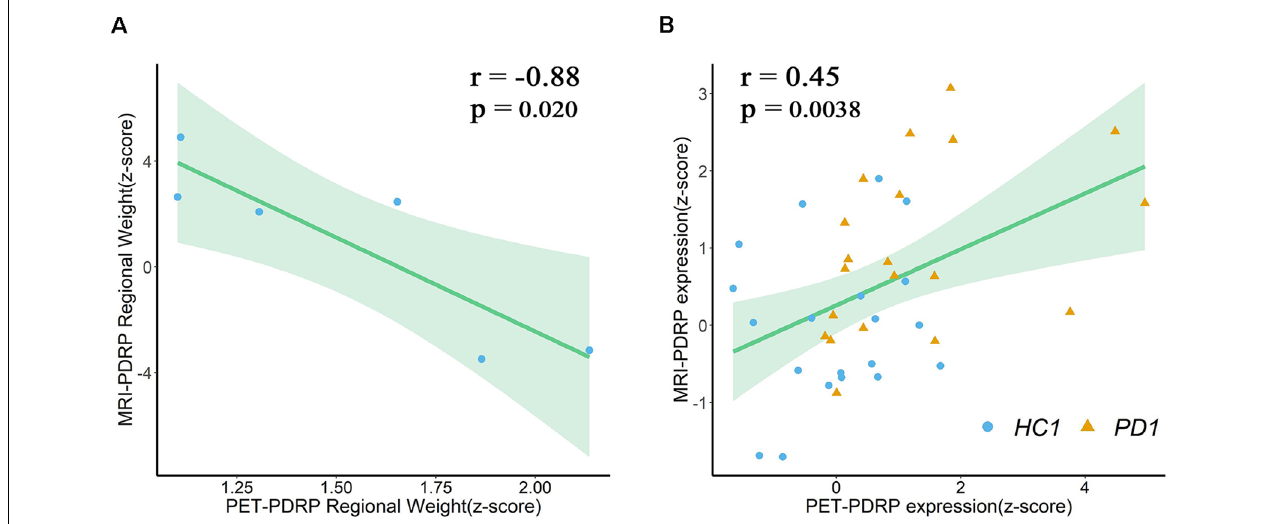
FIGURE 6 | (A) Regional weights on PET-PDRP and MRI-PDRP in a set of salient abnormal brain regions were correlated. (B) PET-PDRP expressions in combination with PD1 patients and healthy controls and MRI-PDRP expressions in the same subjects were correlated. Shaded areas represent 95% confidence of